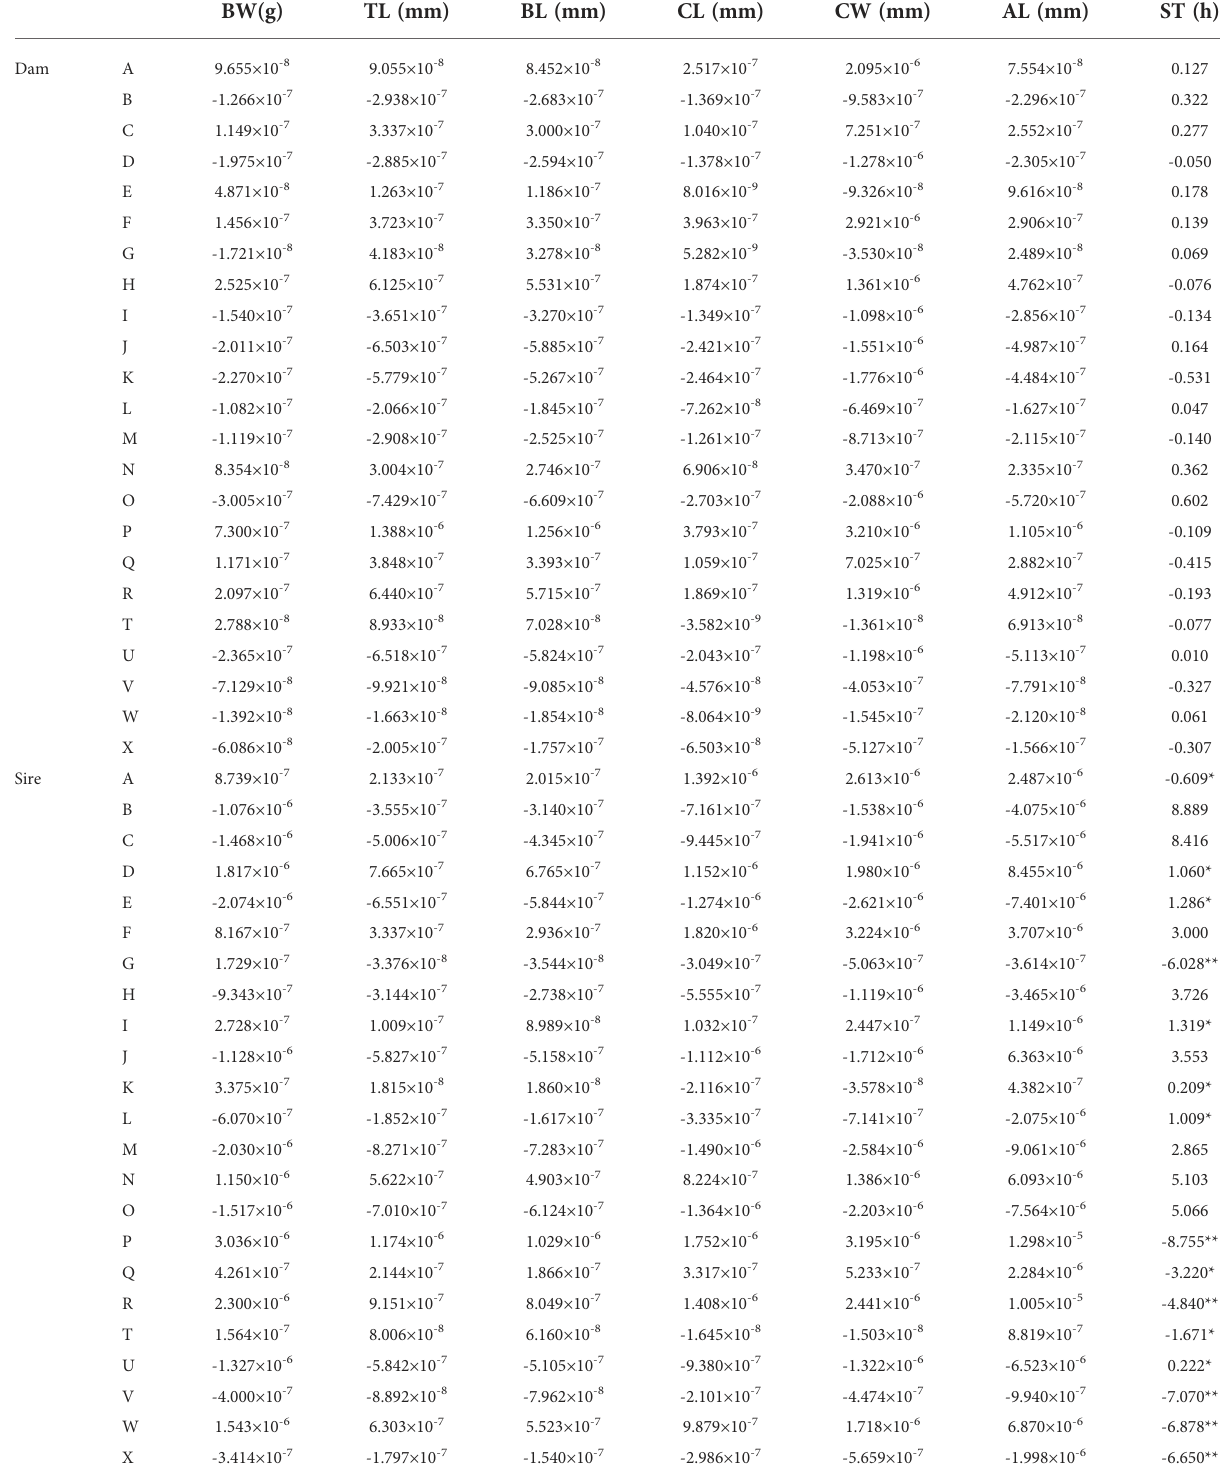
TABLE 2 General combining ability for seven traits in L. vannamei at 15 week